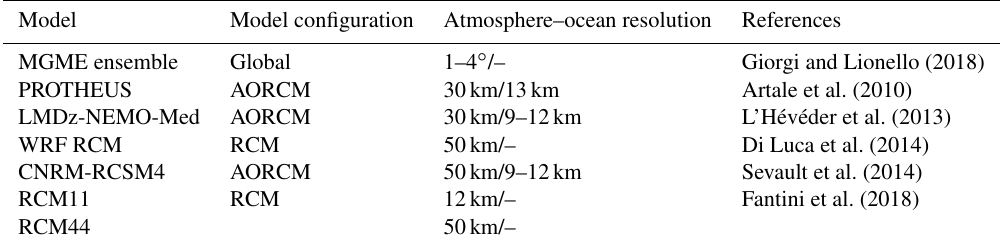
Table 5. Resolution of the different models used in this study to discuss ROM.